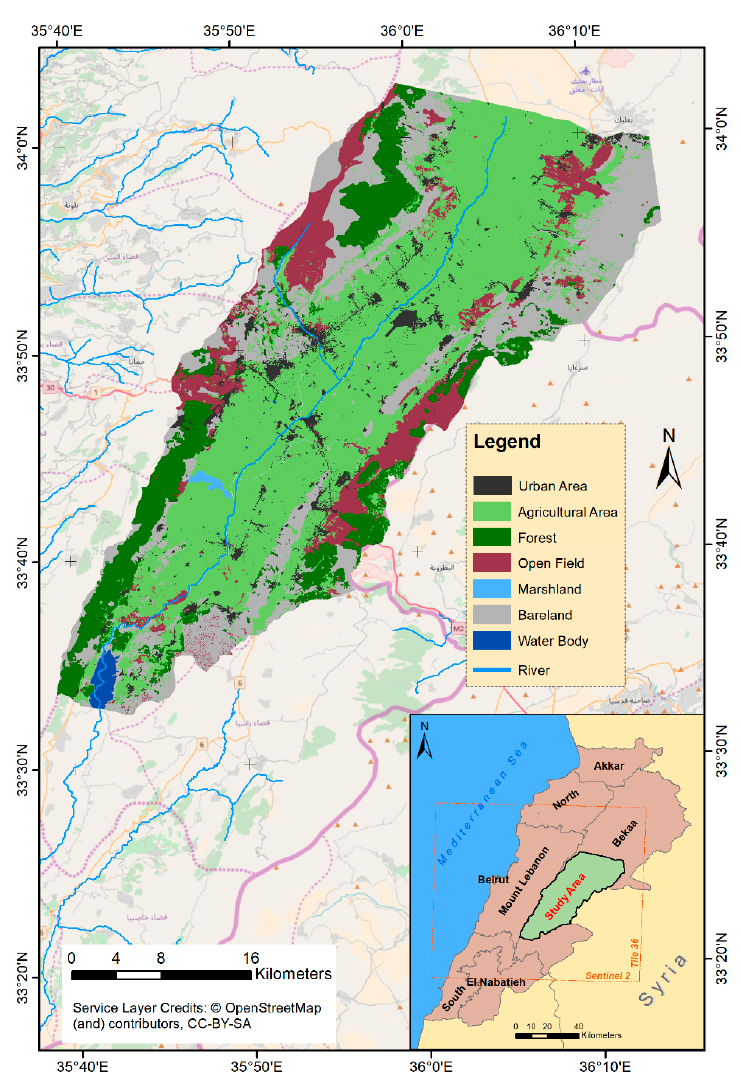
Figure 1. Location of Bekaa plain of Lebanon as well as Sentinel-2 (in orange) tile covering the study area (Landcover/Landuse NCRS-L, 2013).